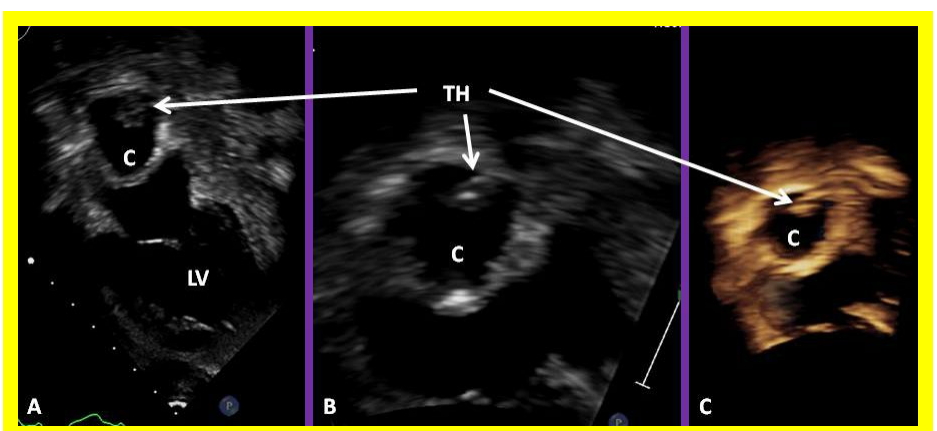
Figure 58. Selected video frames of 2D echocardiograms demonstrating a thrombus (TH) within the conduit (C) in a four chamber apical view ( A ) which was magnified in ( B ). 3D image is shown in ( C ). LV, left ventricle.